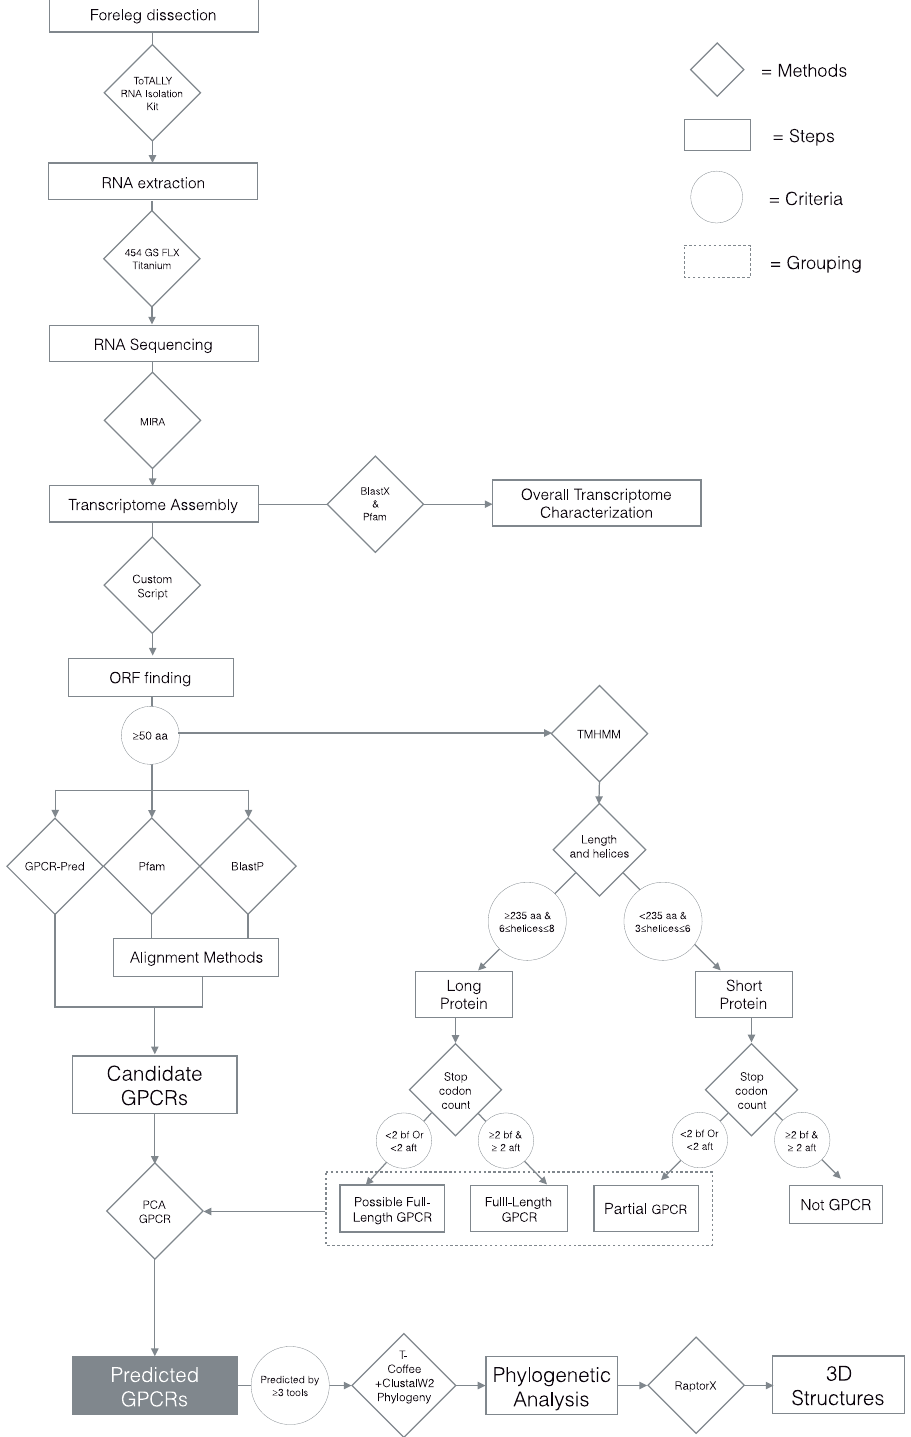
Fig 1. Overall workflow of the study. Visual representation of all steps of the study, from wet-lab procedures to bioinformatic analysis. Steps taken and results are representedby rectangles, methods by rhombuses and criteria by